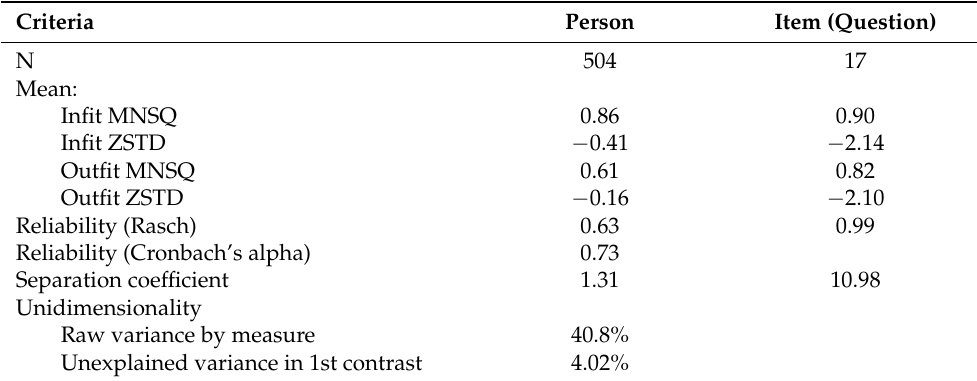
Table 1. The summary statistics of Rasch parameters for